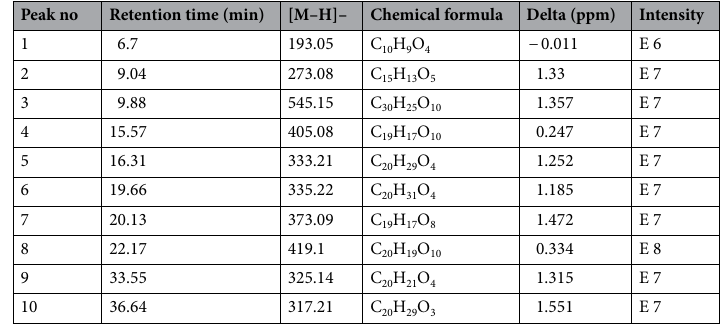
Table 1. Chemical profile of S-6 fraction by reverse-phase LC–MS.